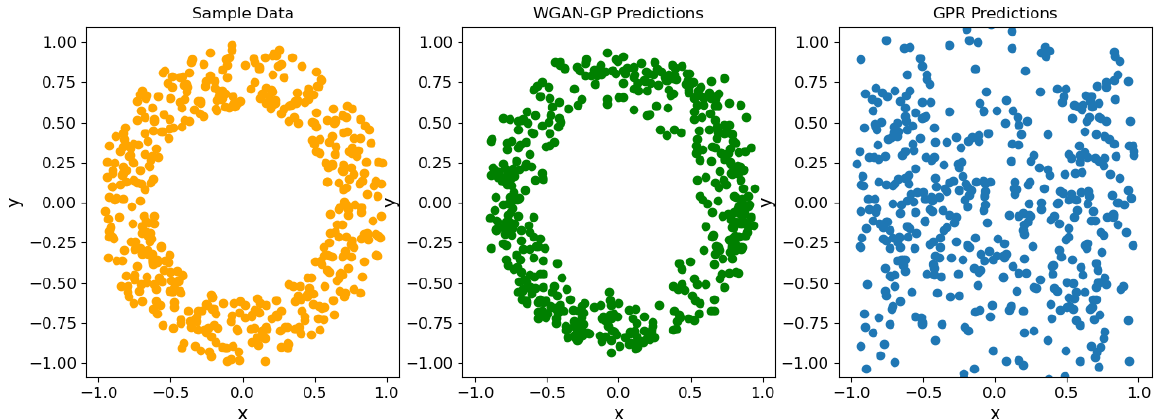
Figure 6. Annulus dataset. The test data is shown on the left, sampled points from the WGAN are shown in the middle and sampled points from the GPR posterior are shown on the